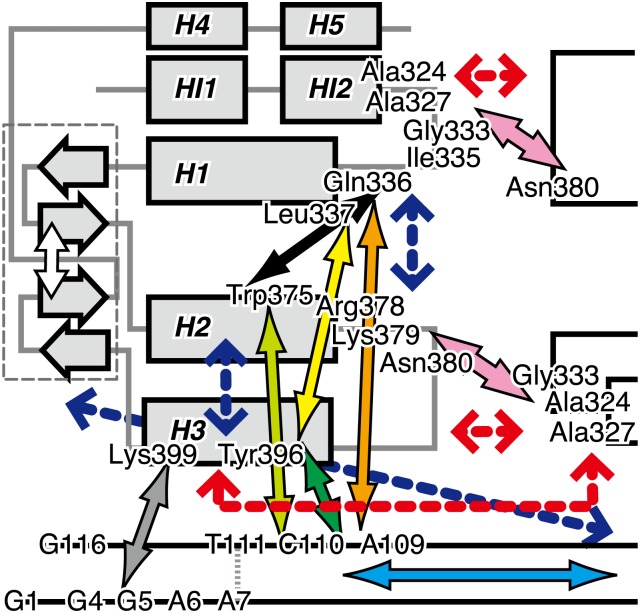
Summary of the correlation network in the (Ets1)2–DNA complex.The colored bold arrows indicate interactions of important residues that exhibited high Betweenness values. The colors of these arrows are consistent with those in the other figures. The red dashed arrows indicate the intermolecular pairs with highly positive correlations between the Ets1 molecules. The blue dashed arrows indicate the pairs with significant gains of correlations by the loss of the partner Ets1 molecule.